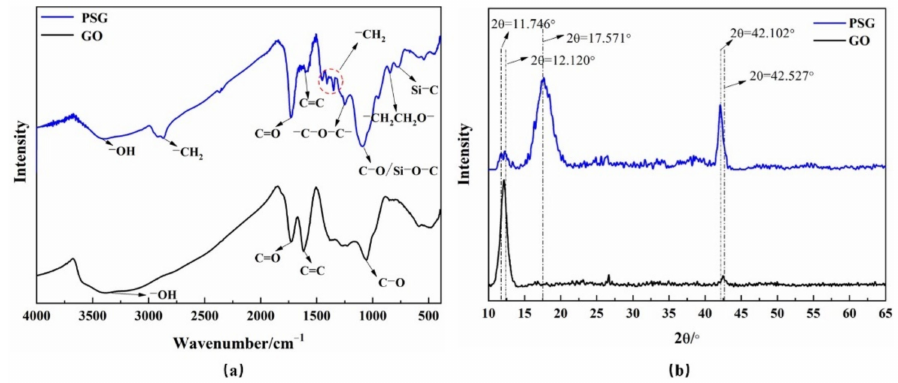
Figure 3. FTIR and XRD spectra of GO and PSG: ( a ) FTIR; and ( b )